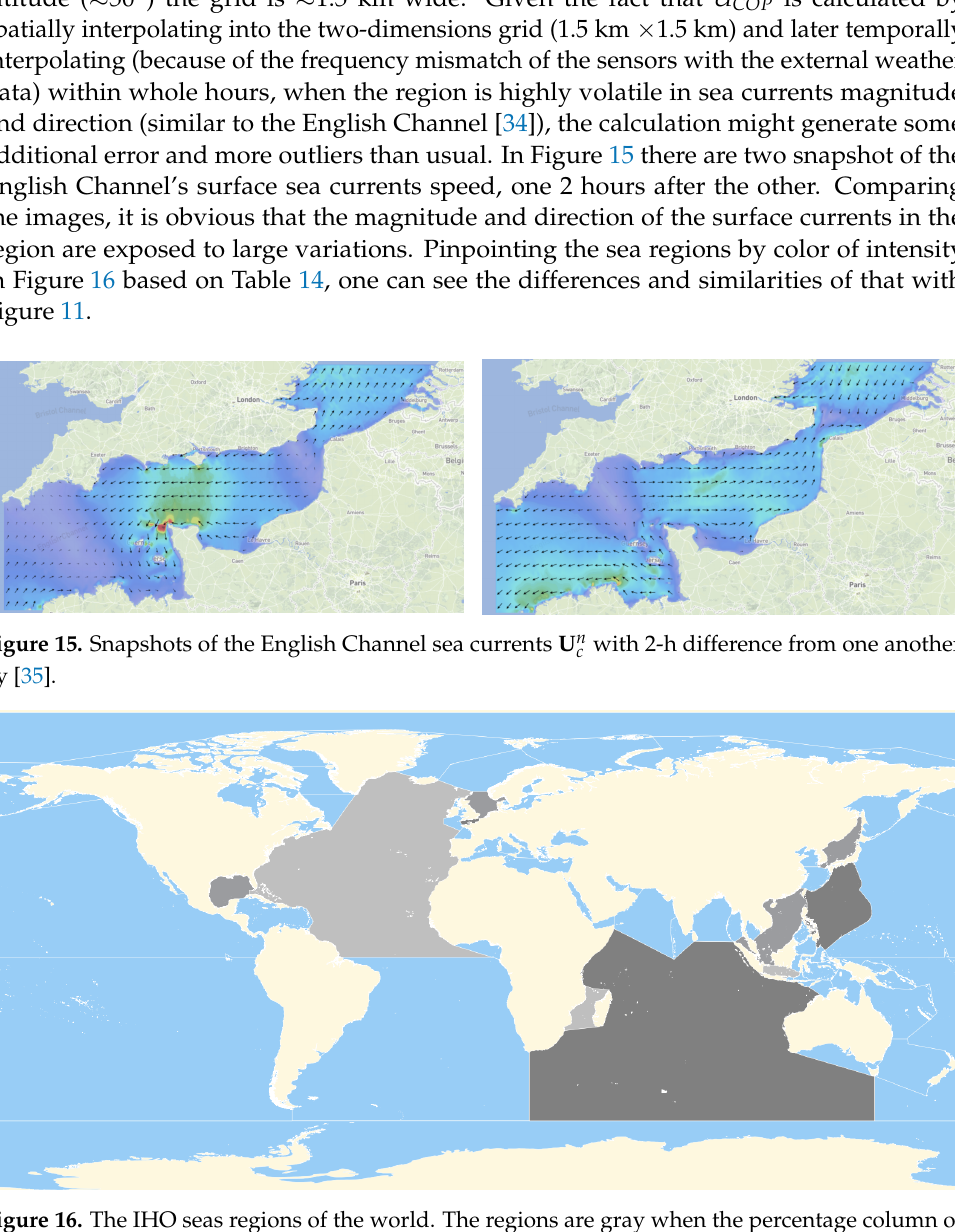
Figure 16. The IHO seas regions of the world. The regions are gray when the percentage column of | U | > 2 kn is greater than 0.63% and it gets darker when it COP